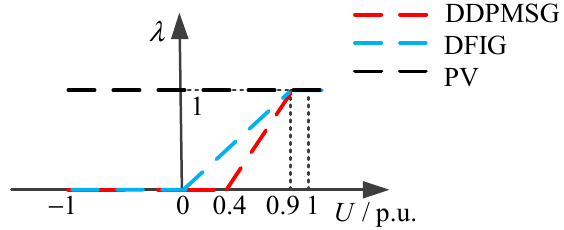
Figure 1. Low-voltage active power management.